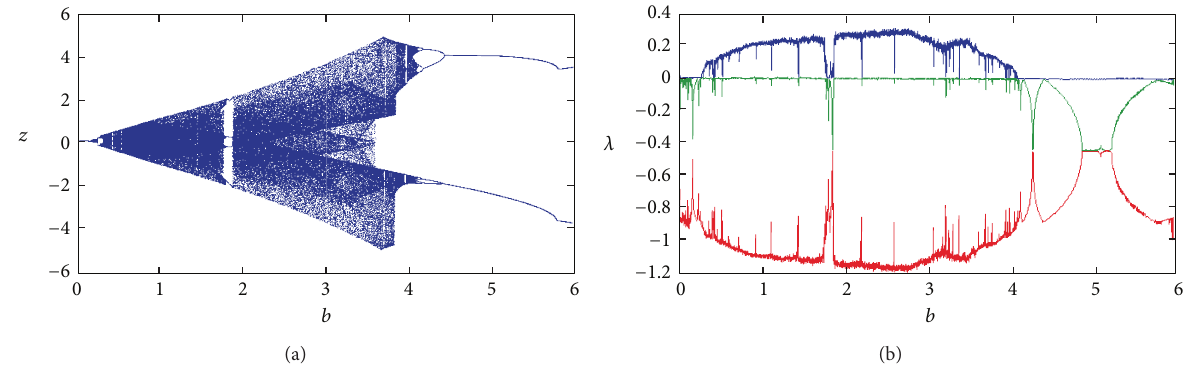
Figure 7: Nonlinear dynamics of system (1) for specific values 𝑎 = 0.1 versus the control parameter 𝑏 . (a) Bifurcation diagram of 𝑥 ; (b) Lyapunov exponent